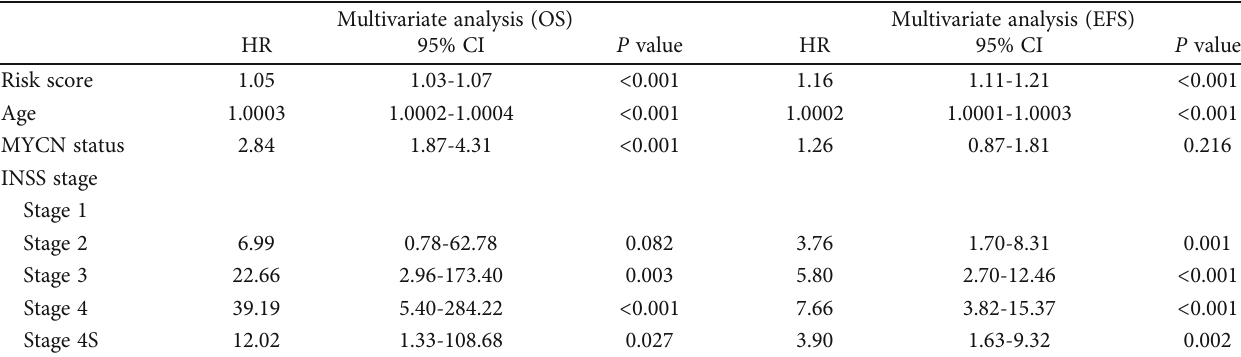
Table 4: Multivariate Cox regression analyses for identifying prognostic clinical characteristics. Multivariate analysis